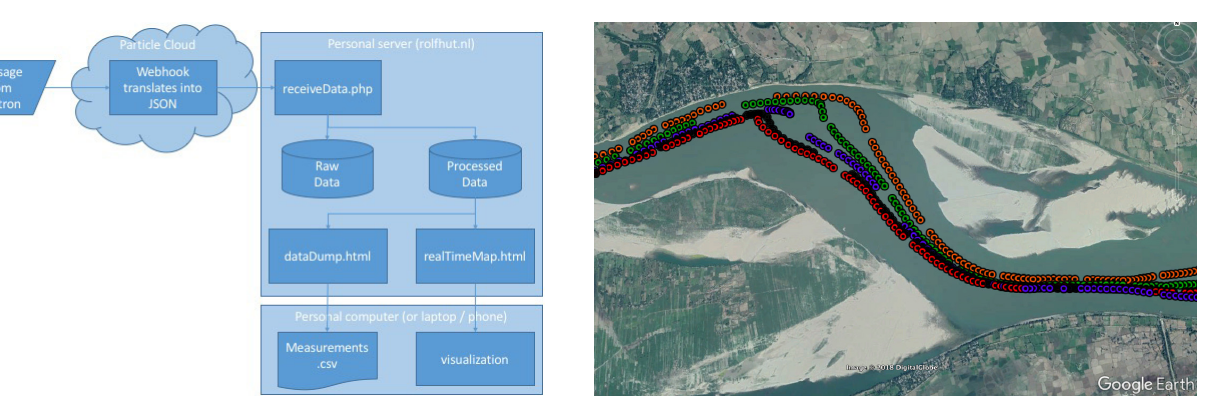
Figure 4. The location measurements for the different floaters (dif- ferent colors) in the Ayeyarwady river near Ngazun. The river flows west to east on this stretch, with downstream being the left side of the figure (© Google Earth,